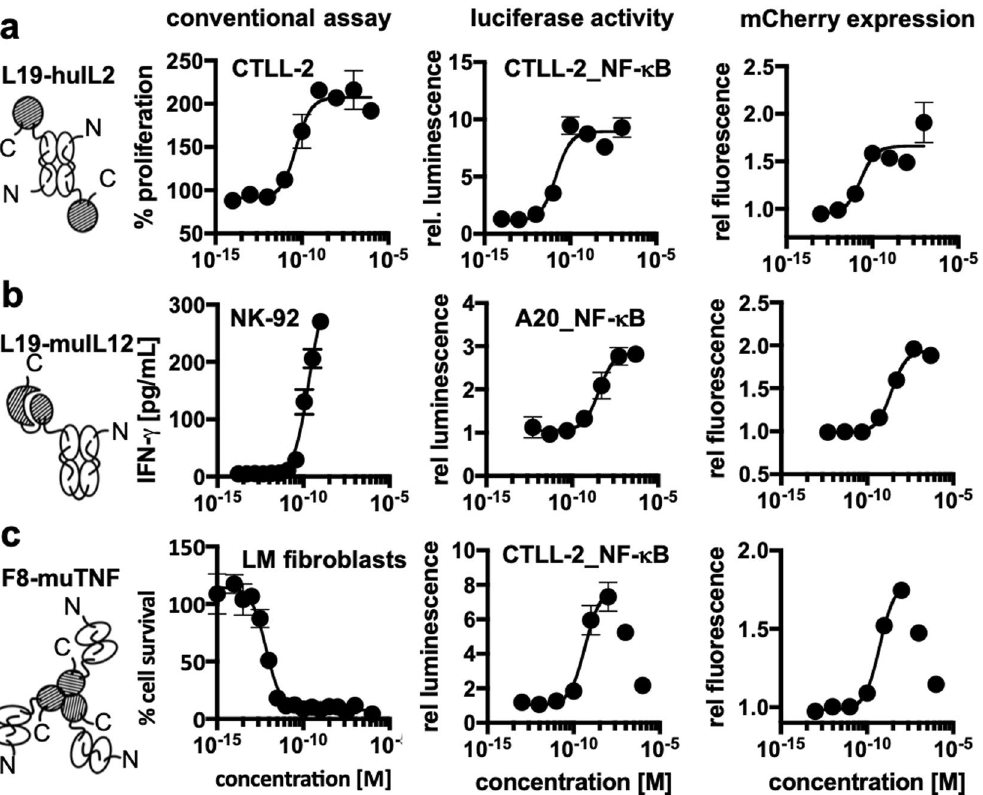
Figure 2. Comparison of the expression of luciferase and mCherry by the newly generated reporter cell lines with the response obtained with the same proteins in the conventional assay. The immunocytokines that were used for this assay are schematically depicted (the antibody moiety is depicted as empty symbols and the cytokine moieties as hatched areas) [a] the proliferation of CTLL-2 and the response of the CTLL-2 reporter cell line triggered by L19-IL2 [b] the production of interferon- γ by NK-92 cells and the response of the A20 reporter cell line triggered by L19-IL12 [c] the cytotoxicity of F8-TNF for L-M fibroblasts compared to the response of the CTLL-2 reporter cell line to F8-TNF. In the cases where a strong hook effect was observed, only the sigmoidal part was used for curve fitting as indicated by the solid